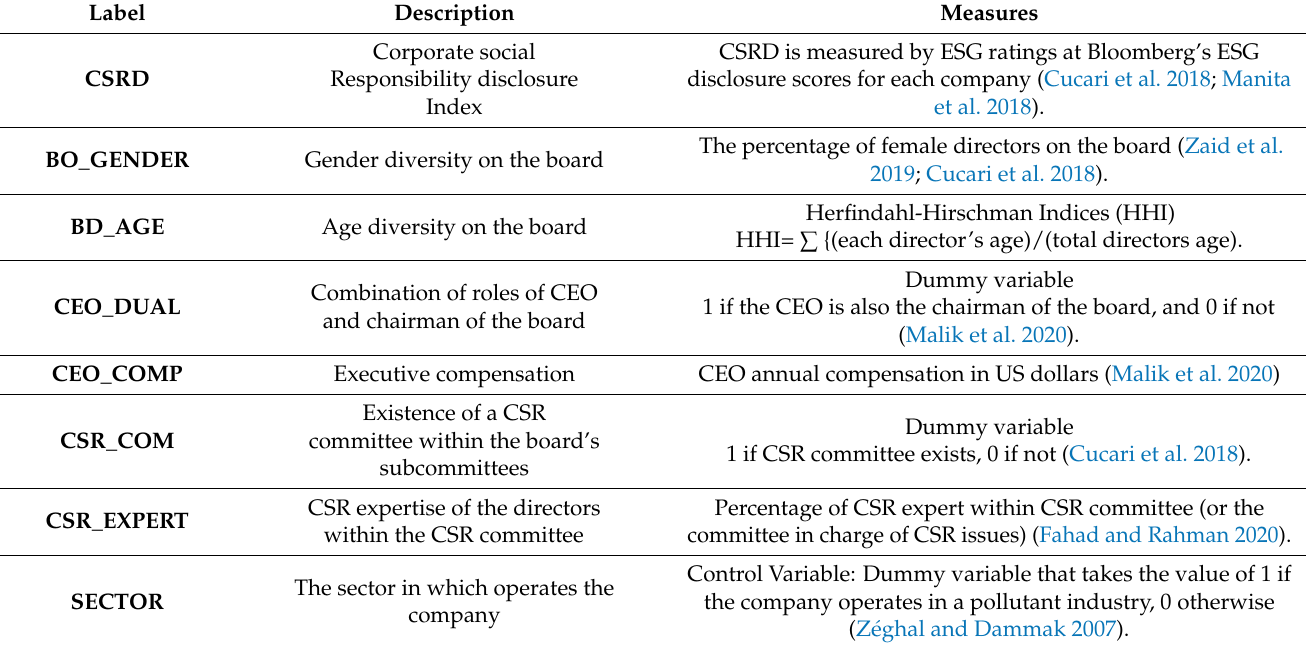
Table 2. Variable